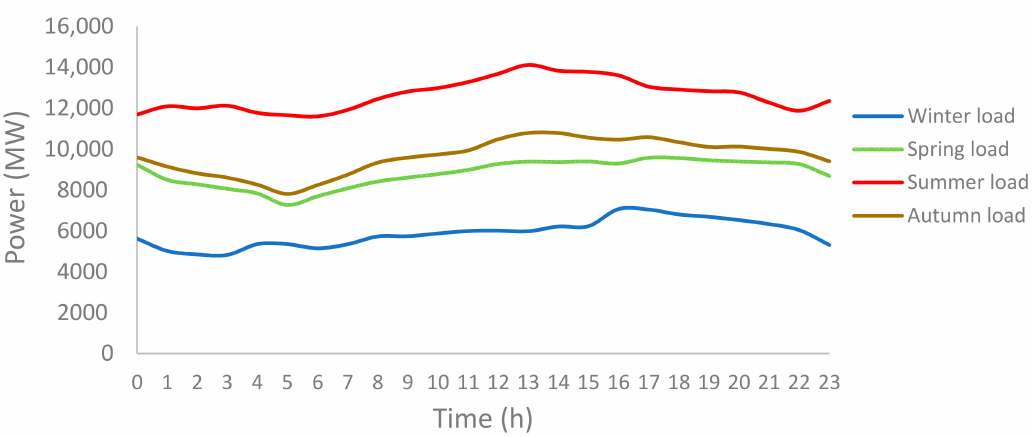
Figure 2. The 2017 average hourly daily load profile for the different seasons in Riyadh [15].